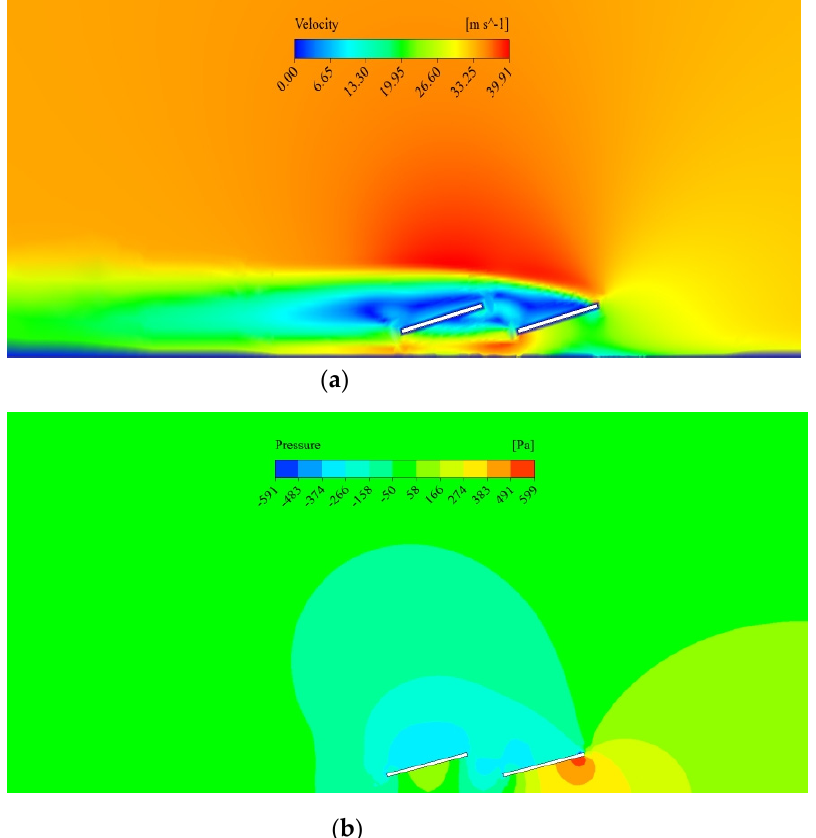
Figure 6. Case I—CFD simulation results for optimum configuration ( a ) velocity contour; ( b ) pressure contour.